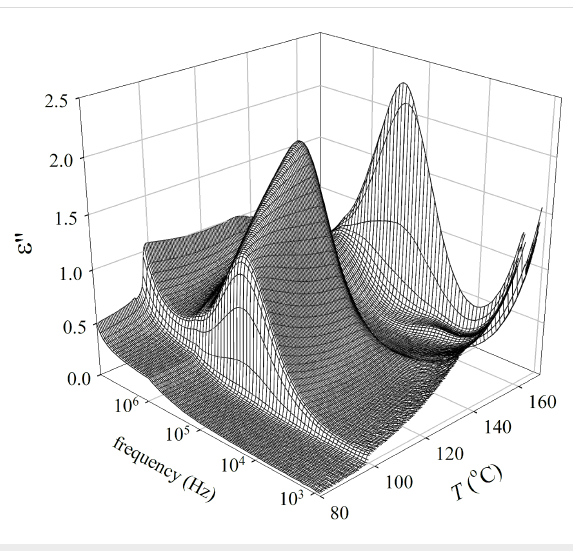
Figure 10: 3-Dimensional plot of the imaginary part of permittivity, ε ’’, versus temperature and frequency for IIb . with decreasing relaxation frequency from 12 to 4 kHz within the temperature interval of the SmC A P A and SmC G phase. At the SmC A P A –SmC G phase transition, Δε of the lower frequency mode exhibits a local maximum (see the inset of Figure 11).